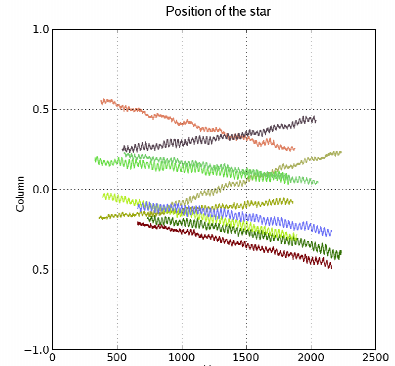
Figure 13 : position of the star measured on 10 images (CMG velocity equal to